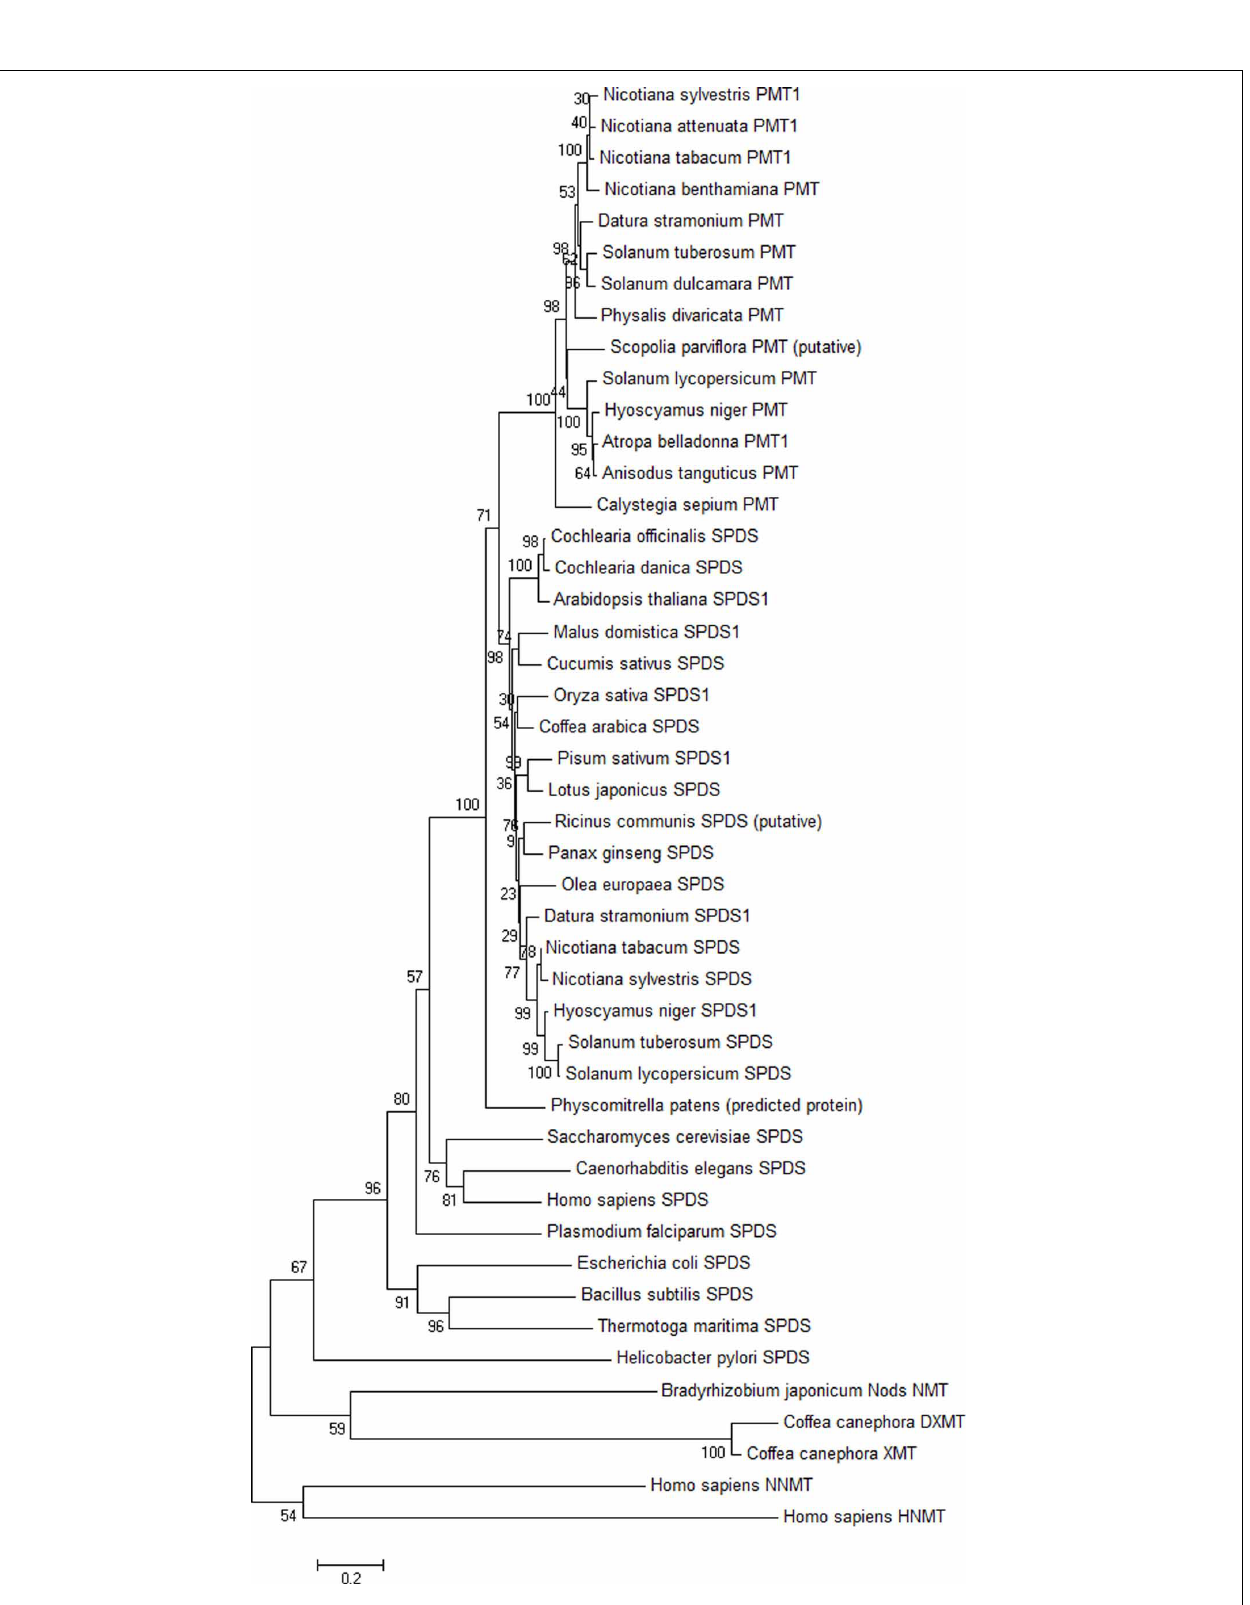
sequences are given in Table 3 . Bootstrap values (1000 replicates) are shown next to the branch points. Bar length indicates 0.2 exchanges per